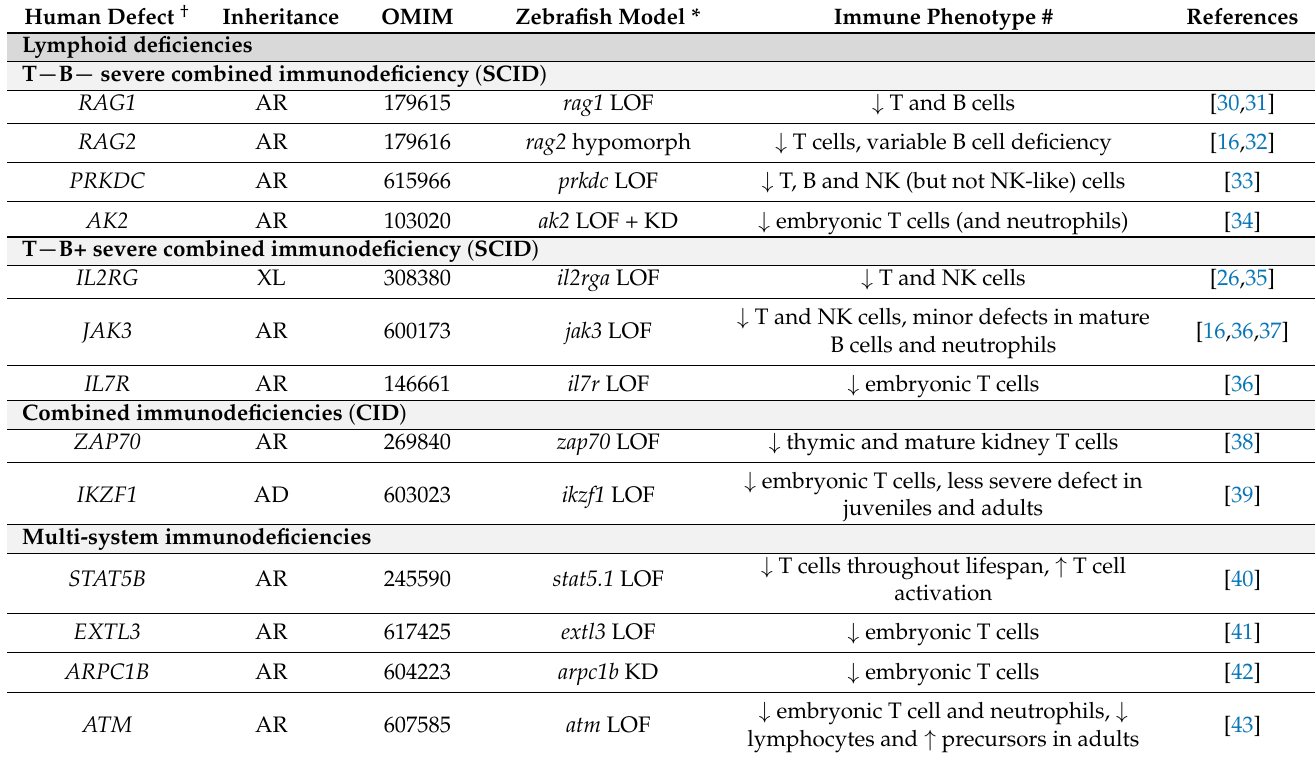
Table 1. Zebrafish models of human